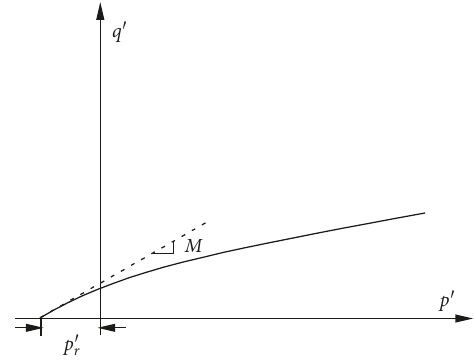
Figure 6: Conceptual shear yield trajectory in the p